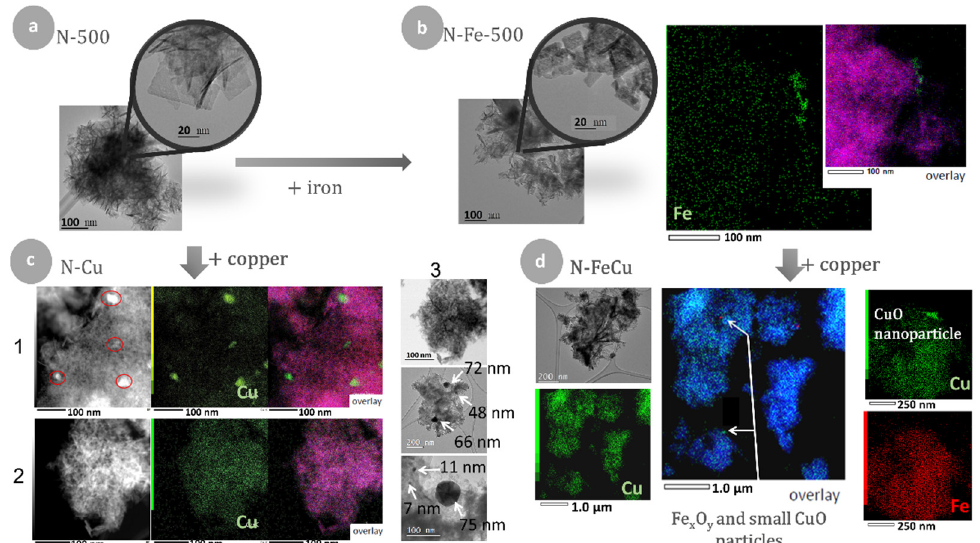
Figure 11. ( a ) N-500: BF-STEM image of platelet particles; ( b ) N-Fe-500: BF-STEM image of iron containing particles with EDXS mapping of iron and overlay micrograph. ( c ) HAADF and BF STEM images with EDXS mappings of catalyst sample N-Cu without iron presence: 1-area with visible copper oxide particles; 2-area without visible copper oxide particles; 3-located copper oxide particles of different sizes. ( d ) TEM image and EDXS mappings of N-FeCu sample where very rare small nanoparticles of Fe x O y and CuO are visible (indicated with white arrows in overlay map- ping).